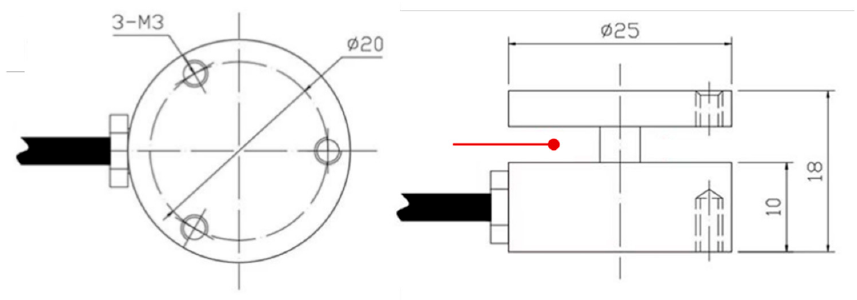
Figure 3. The size of pressure sensor. The red point is the thermocouple temperature measurement point.